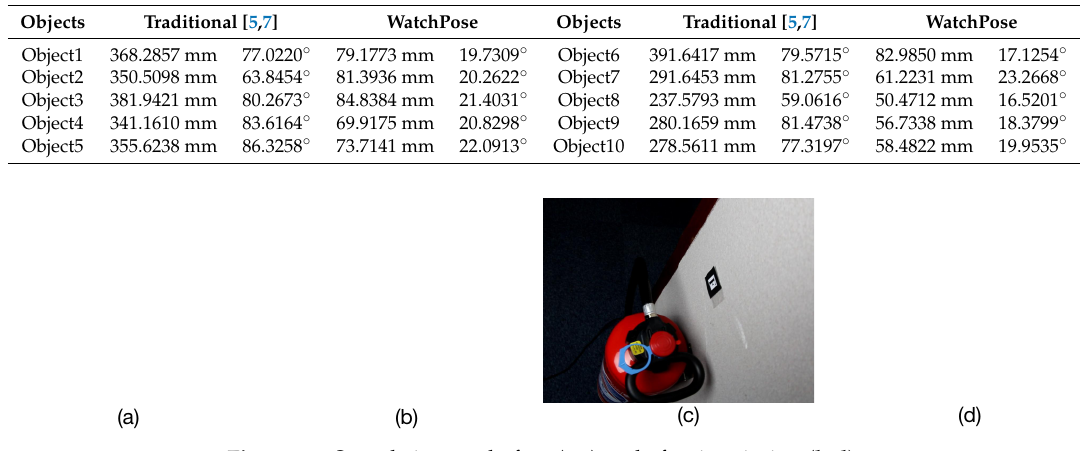
Figure 13. Sample images before ( a , c ) and after inpainting ( b , d ). Table 3. Pose estimation using with-marker/no-marker data for